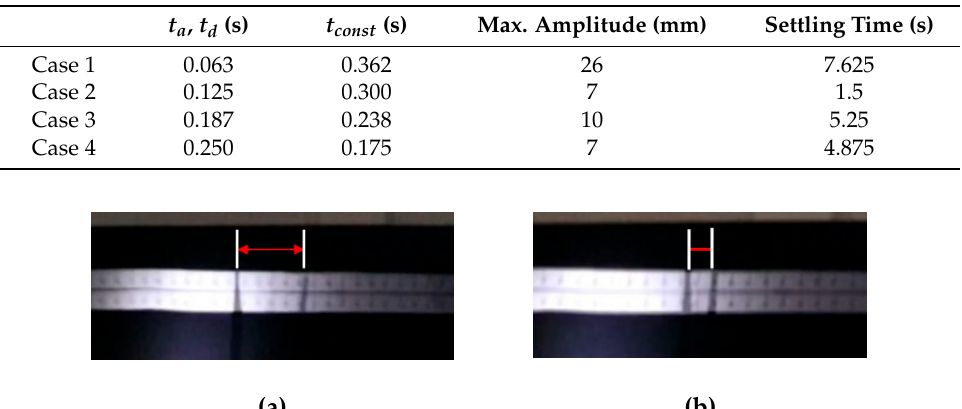
maximum velocity of 1000 mm/s. a